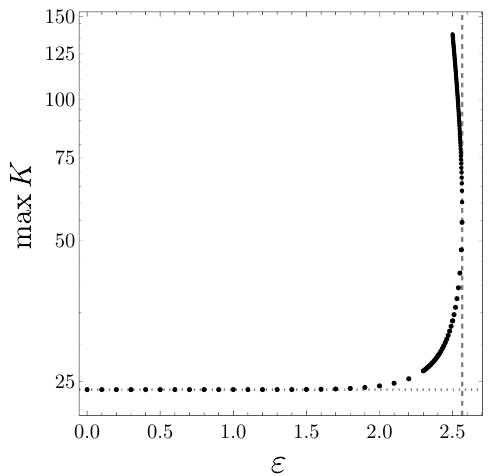
Figure 2 . The log-linear plot of the maximum of the Kretschmann scalar against the rotation parameter for the soliton solutions. The dashed gridline marks " c , and the dotted line shows the max K = 24 =L 4 for pure AdS 4